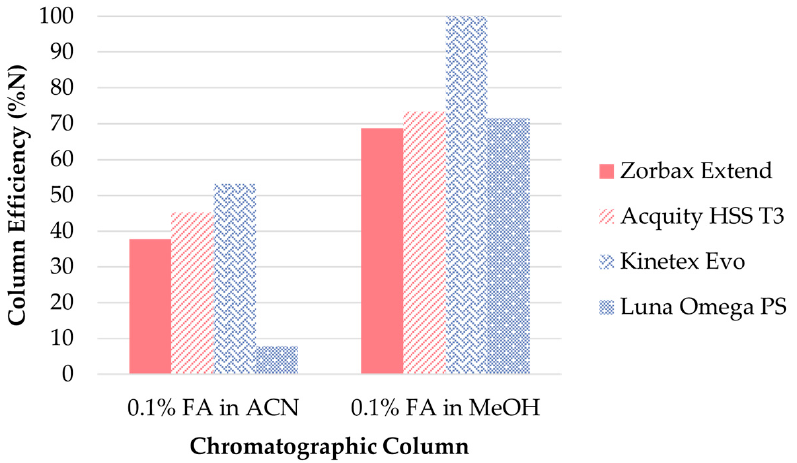
Figure 3. Comparison of the separation efficiency of clenbuterol in different stationary phases.